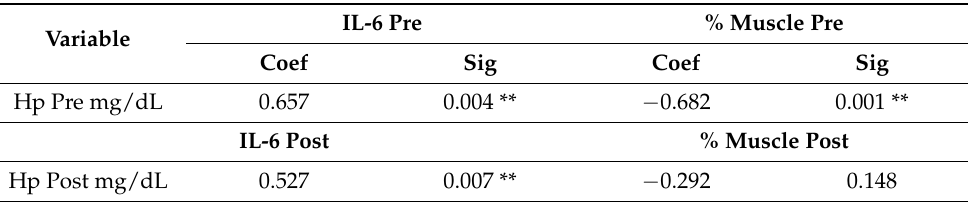
Table 2. Correlations of haptoglobin (Hp) with Interleukin 6 (IL-6) and muscle mass percentage (% muscle), before (Pre) and after (Post)